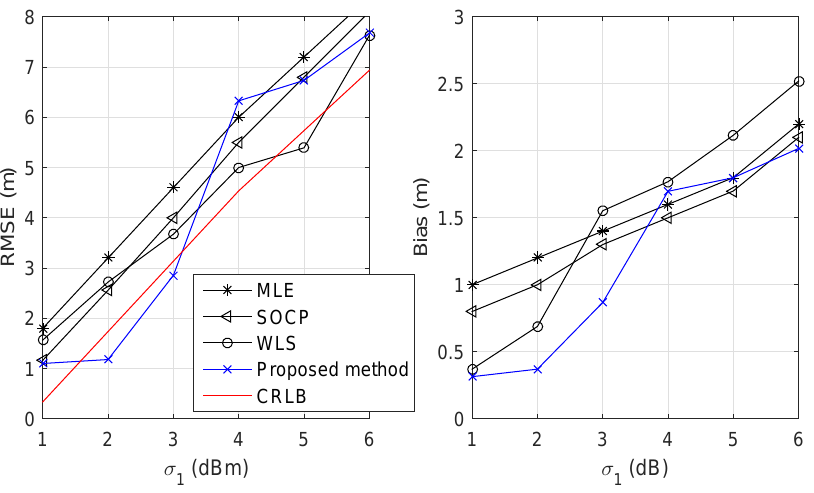
Figure 6. RMSE and bias versus standard deviation of the RSS measurement errors σ 1